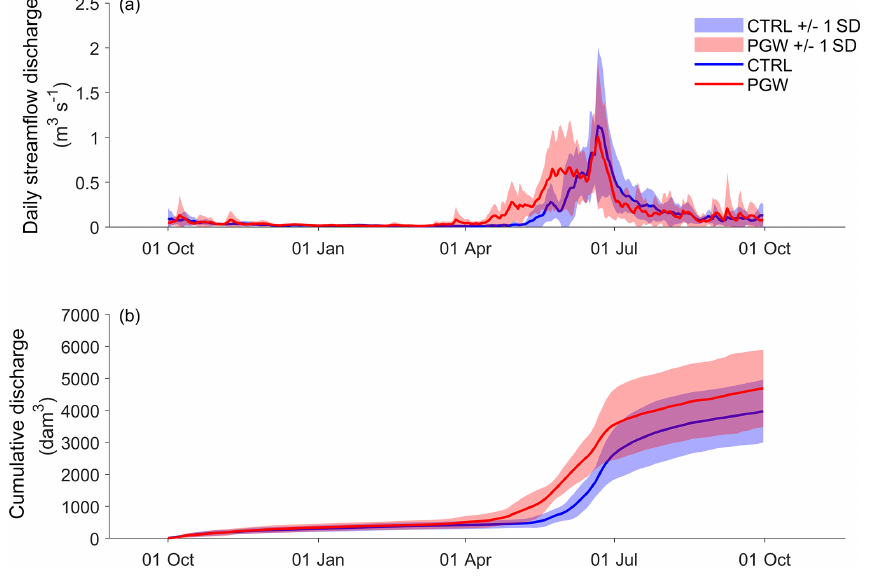
Figure 10. Simulated mean annual (a) Marmot Creek daily streamflow discharge and (b) cumulative discharge for the WRF CTRL and PGW periods. The line represents the mean and the shadow represents the standard deviation of the streamflow discharges over the 8 water years.